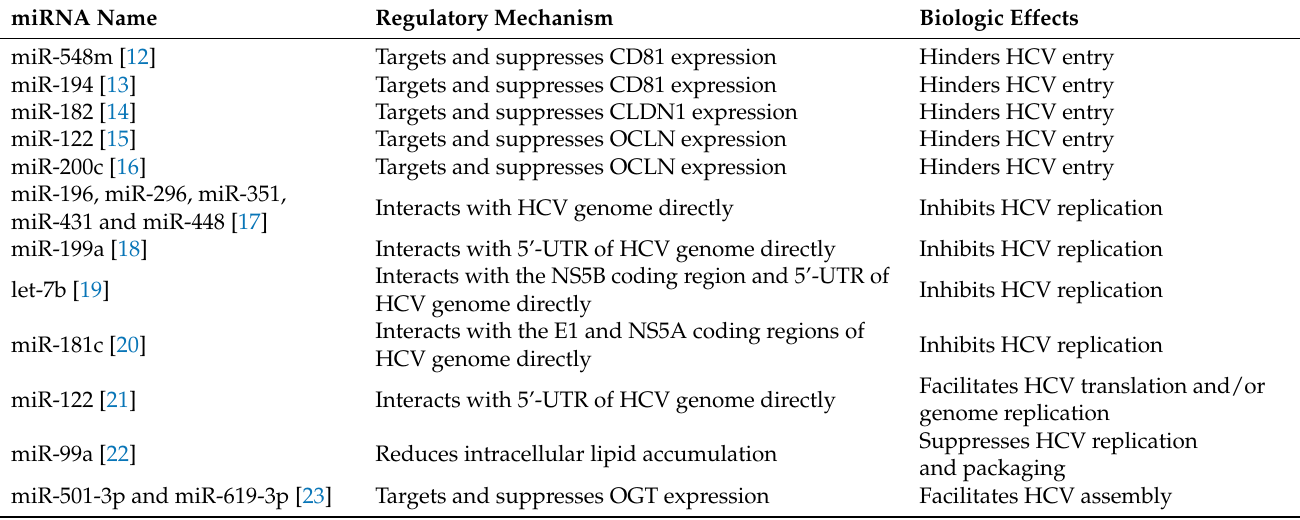
Table 1. miRNAs involved in different stages of HCV life